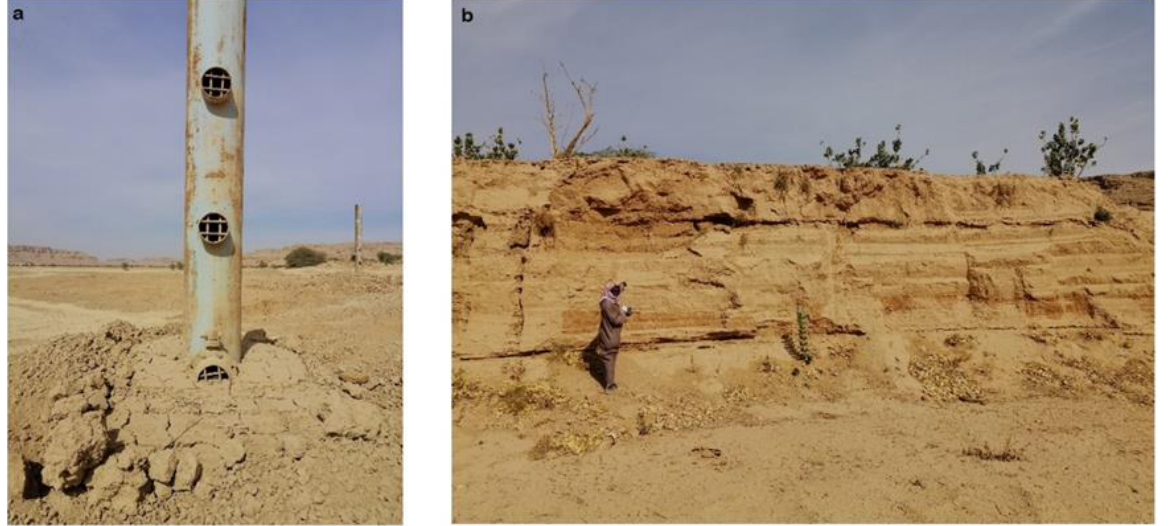
Figure 7. ( a ) Sediment blocking water entry in recharge wells drilled in dam reservoir and ( b ) sedi- ment deposition in a reservoir bed in a recharge dam in central Saudi Arabia.